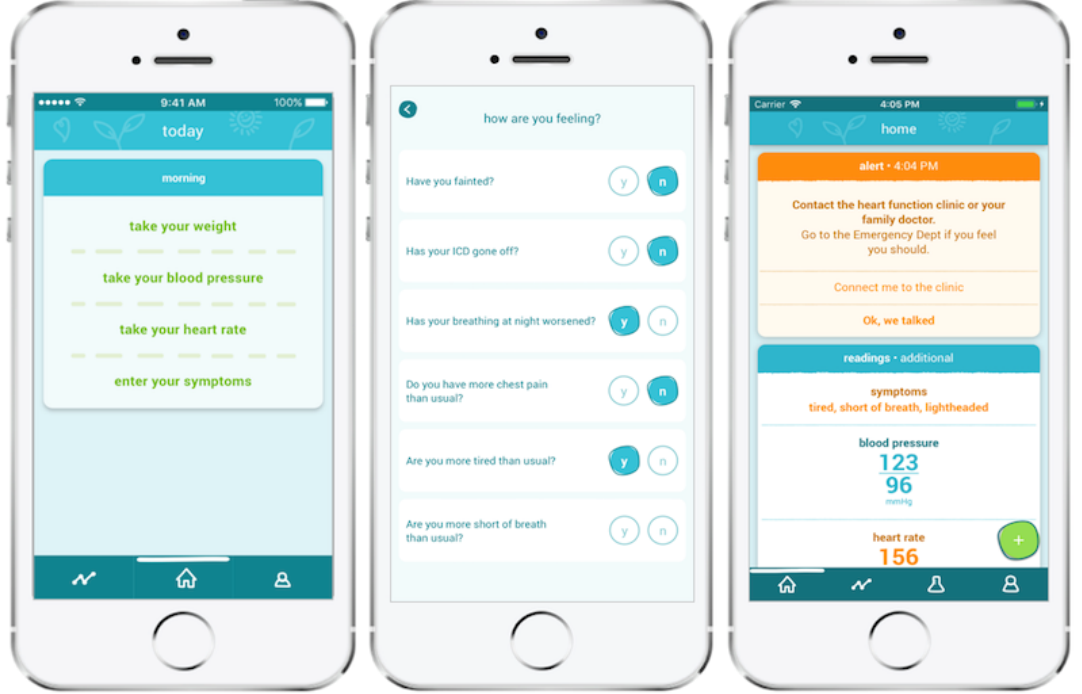
Figure 1. Medly app showing instructions for required readings (screen 1), the symptoms questionnaire (screen 2), and personalized self-care feedback (screen